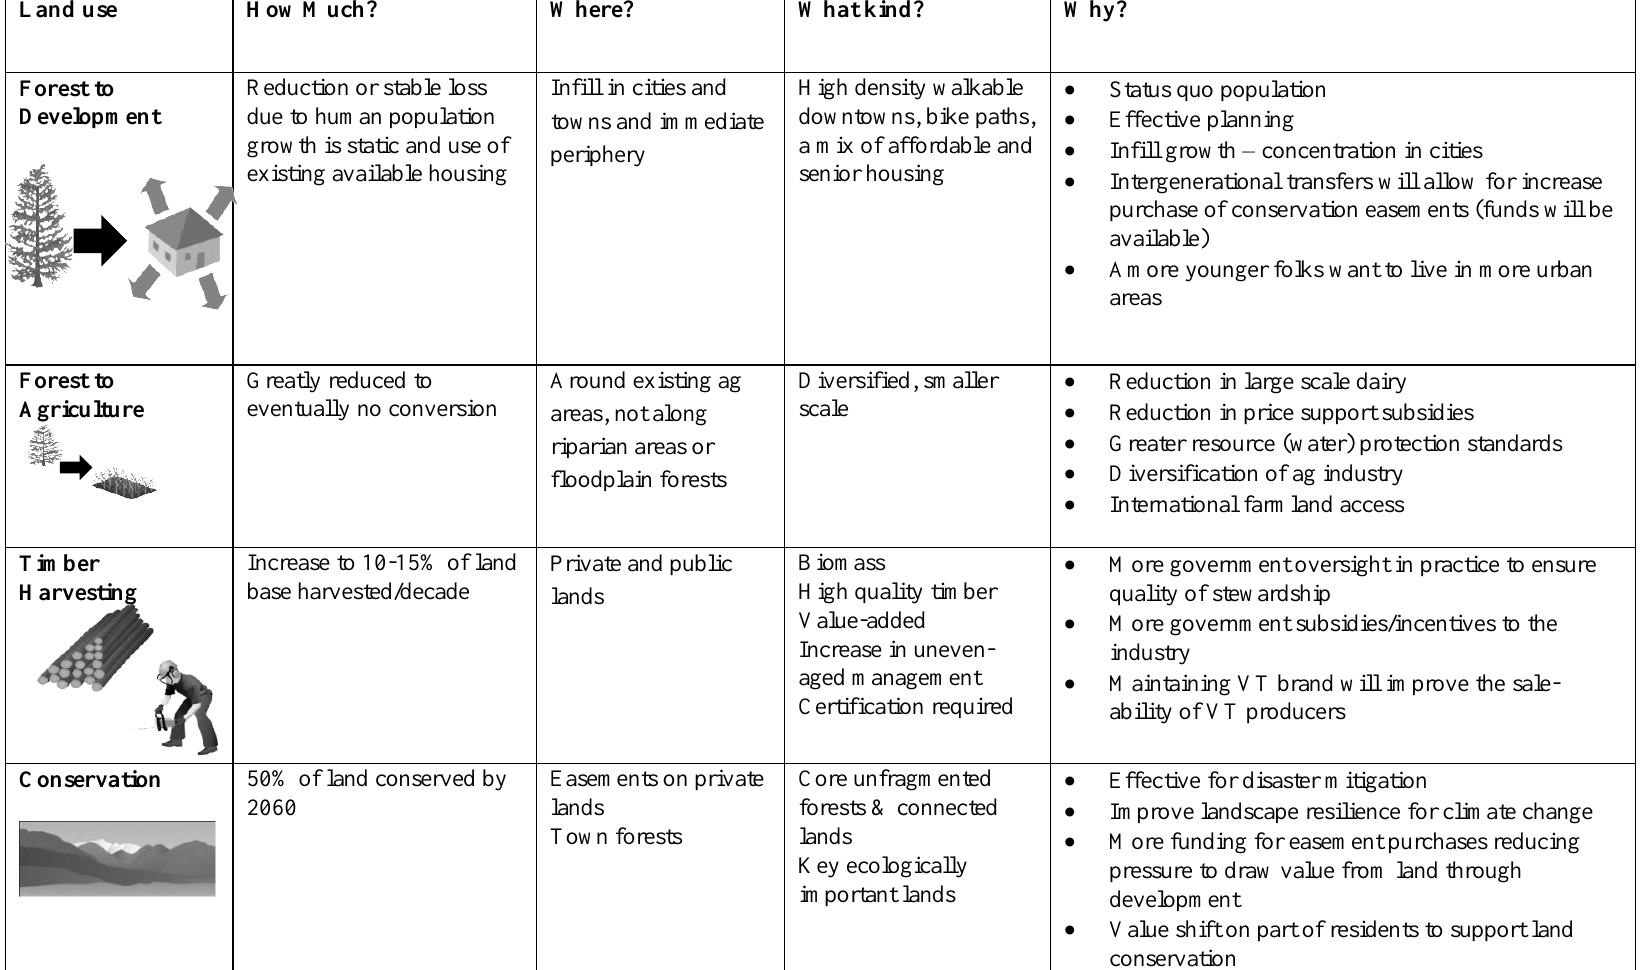
Table A2.1. Scenario 1: Connecting, Protecting, and Thriving (CPT) Land